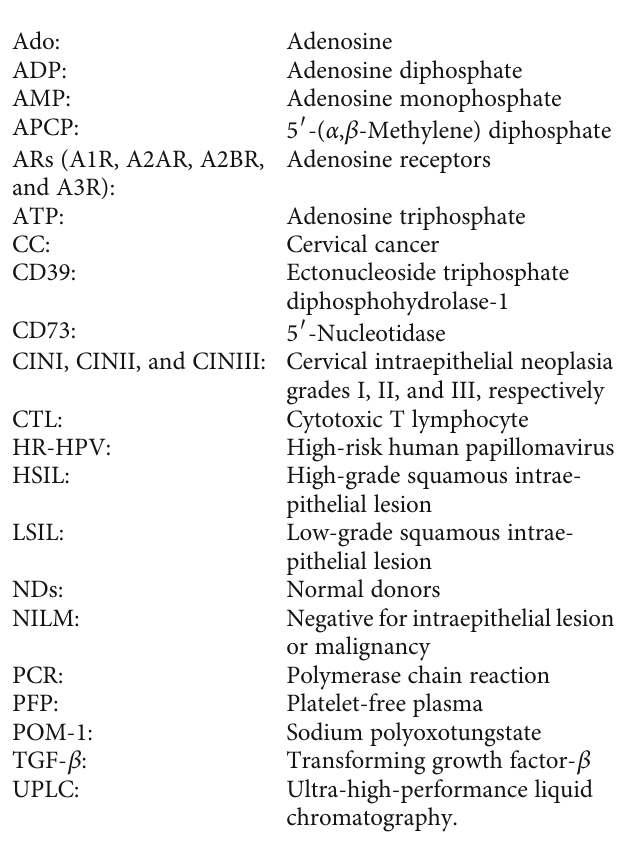
Supplementary Figure 1: detection of the HPV L1 gene in cervical samples from NILM women. Expression of the L1 gene in cervical samples was detected by PCR as described in Section 2. The absence (left) or presence (right) of L1 is shown in samples from NILM women. As a positive control, DNA from the HeLa cell line (HPV-18 + ) was used. The expression of the β -actin gene in all samples was used as an internal control. The size of the fragment (bp) of each gene is indicated. (Supplementary